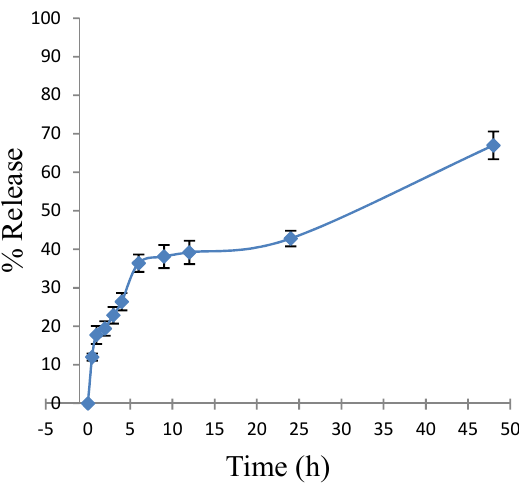
Figure 13. Drug release study of micelles made of star-shaped polymer-VLB formulation.